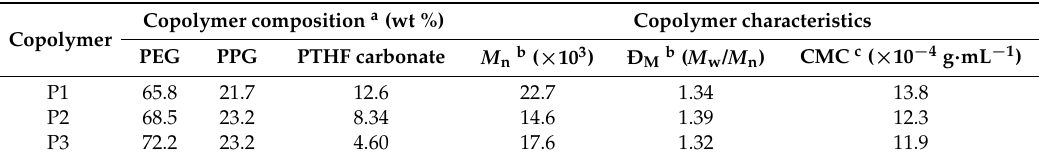
Table 1. Molecular characteristics of poly(PEG/PPG/PTHF carbonate urethane)s.